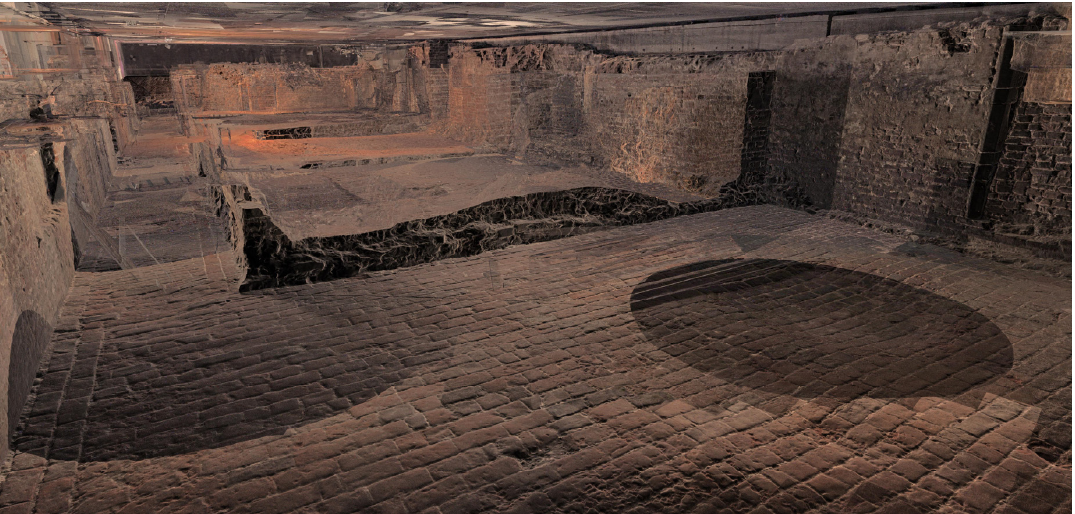
Figure 14. 3D point cloud colourised with the internal camera.